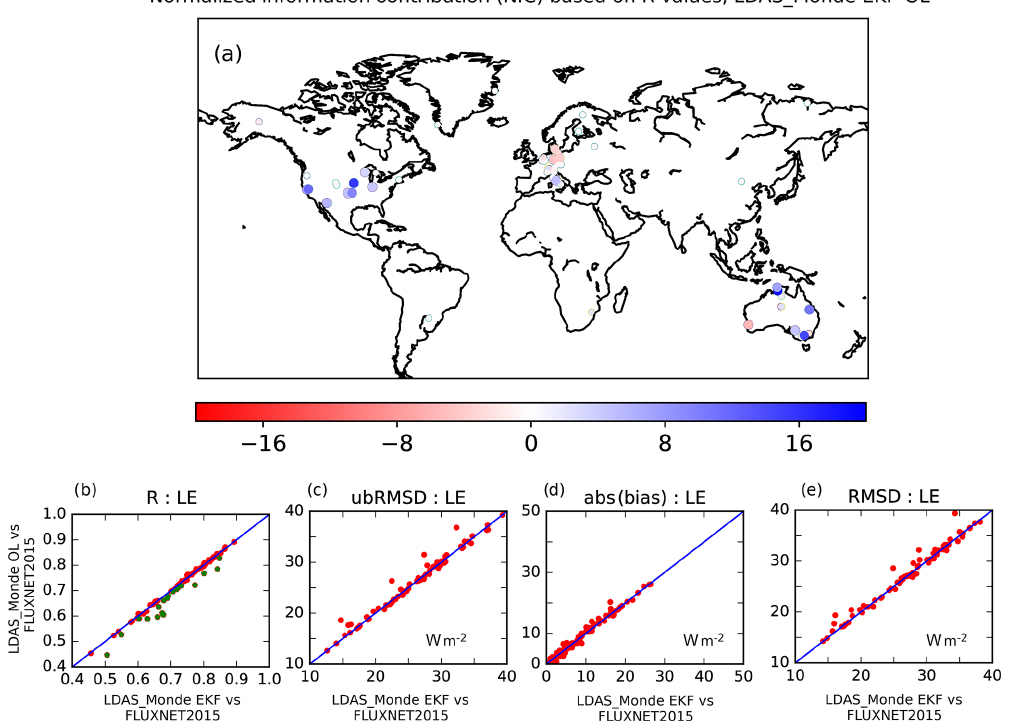
Figure 7. (a) Map of the normalized information contribution (NIC, Eq. 2) applied to correlation values between evapotranspiration from LDAS_ERA5 analysis (open-loop) and observations from the FLUXNET 2015 synthesis dataset. NIC scores are classified into two cate- gories: (i) negative impact from the analysis with respect to the model with values smaller than − 3% (red circles, 5 stations) and (ii) positive impact from the analysis with respect to the model with values greater than + 3% (blue circles, 20 stations). Stations presenting a neutral impact with values between − 3% and + 3% (60 stations) are reported as small dots. Note that at this scale some stations are overlapping. ( b , c , d and e ) Scatter plots of R , ubRMSD, absolute bias and RMSD between LDAS_ERA5 open-loop and the 85 stations from the FLUXNET 2015 ( y axis) and LDAS_ERA5 analysis and the same pool of stations ( x axis). The set of 20 stations for which the analysis has a positive impact on R values at NIC R greater than + 3 is reported in (a) in